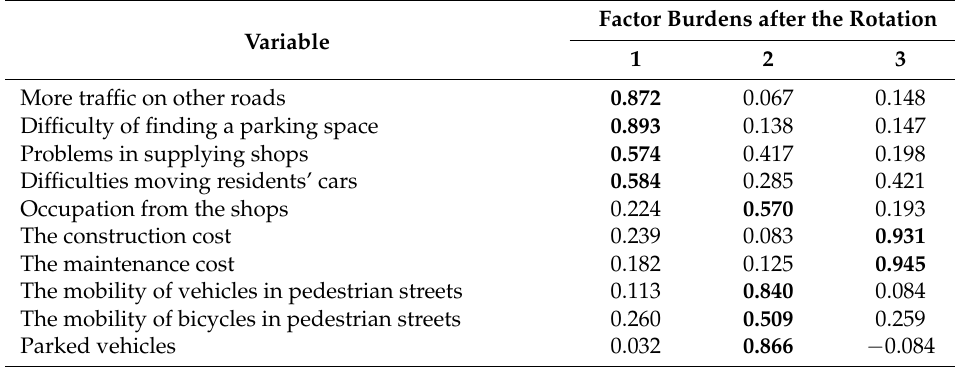
Table 3. Table with factor burdens after rotation, for the multivariable disadvantages of the pedestrian